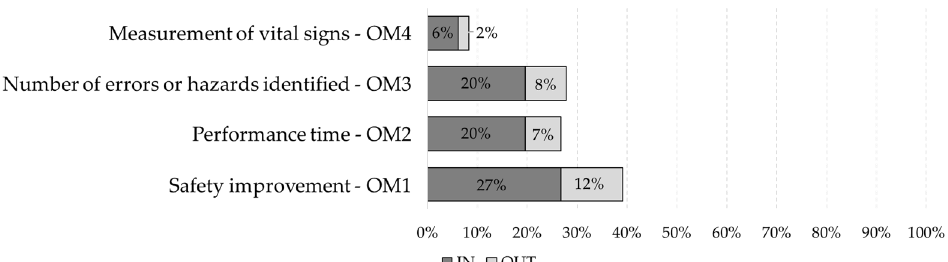
Figure 12. Number of items by type of evaluation of the objective method and number evaluating within and outside the experience.